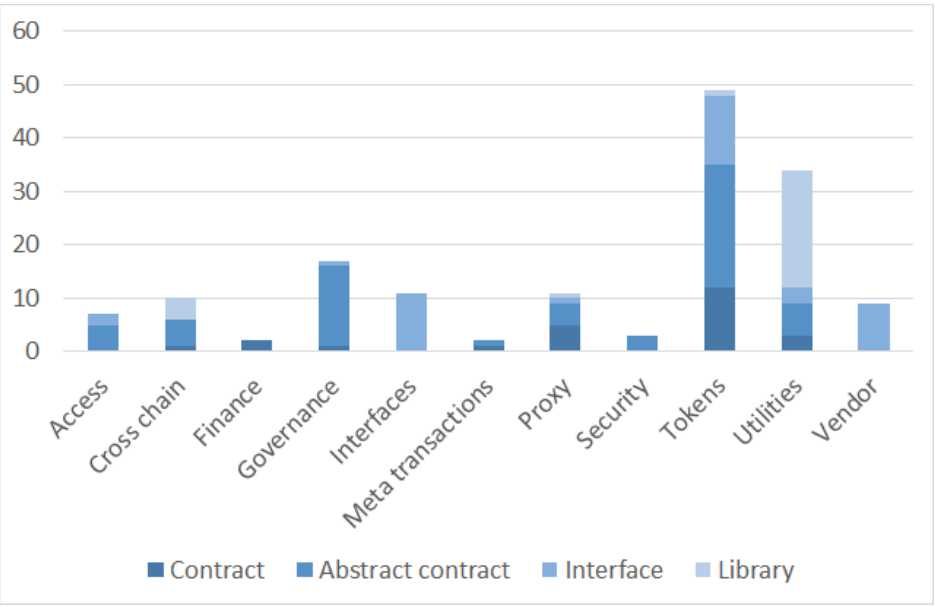
Figure 3. OpenZeppelin main smart contract modules in relation to the contract